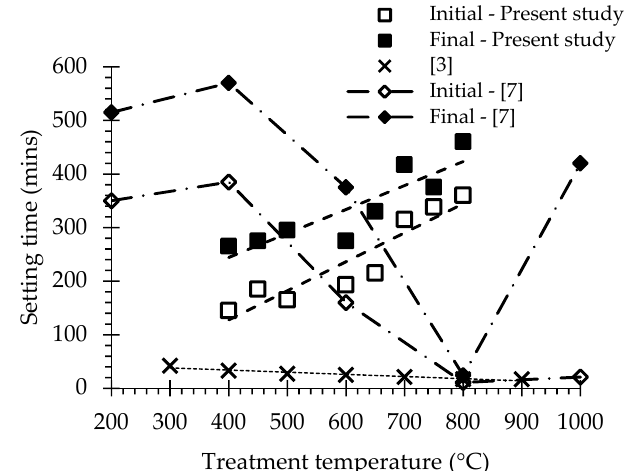
Figure 8. Water demand of RC treated at different temperatures.